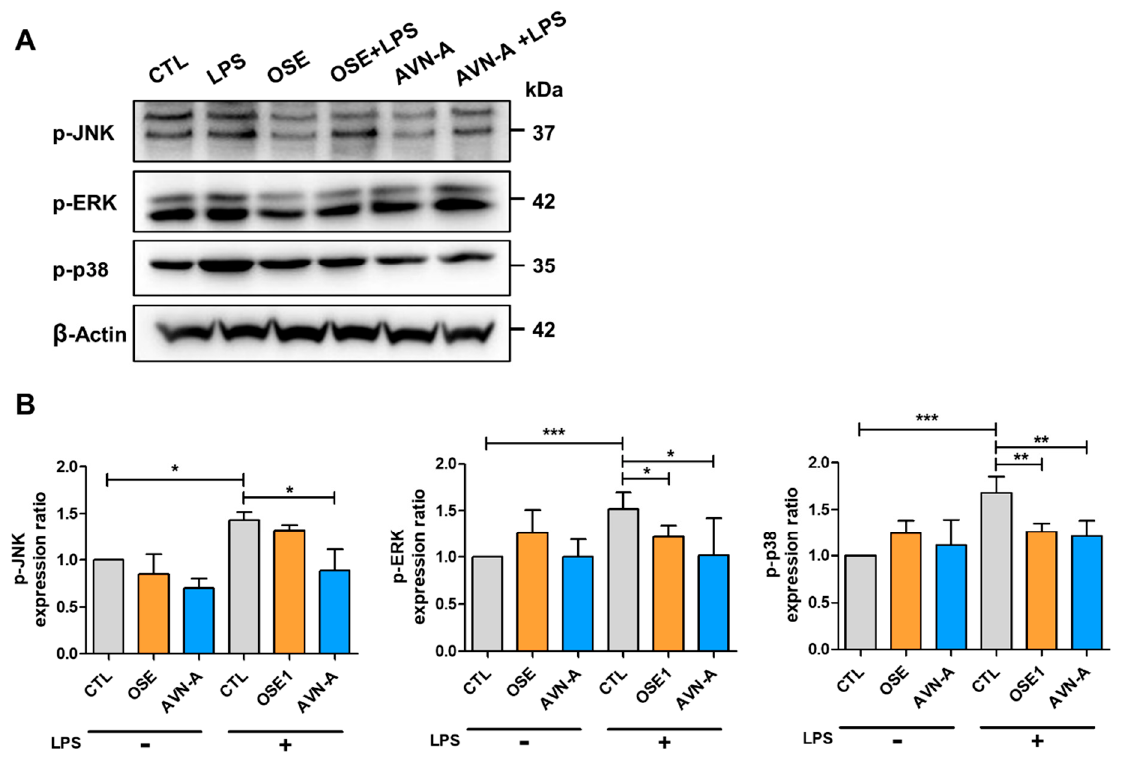
Figure 7. Inhibitory effects of OSE and AVN-A on the phosphorylation of c-JNK, ERK, and p38. ( A ) The expression levels of p-JNK, p-ERK, and p-p38 were measured by Western-blot analysis. ( B ) Validation of differentially expressed proteins by Western-blot analysis. * p < 0.05, ** p < 0.01, *** p < 0.001.